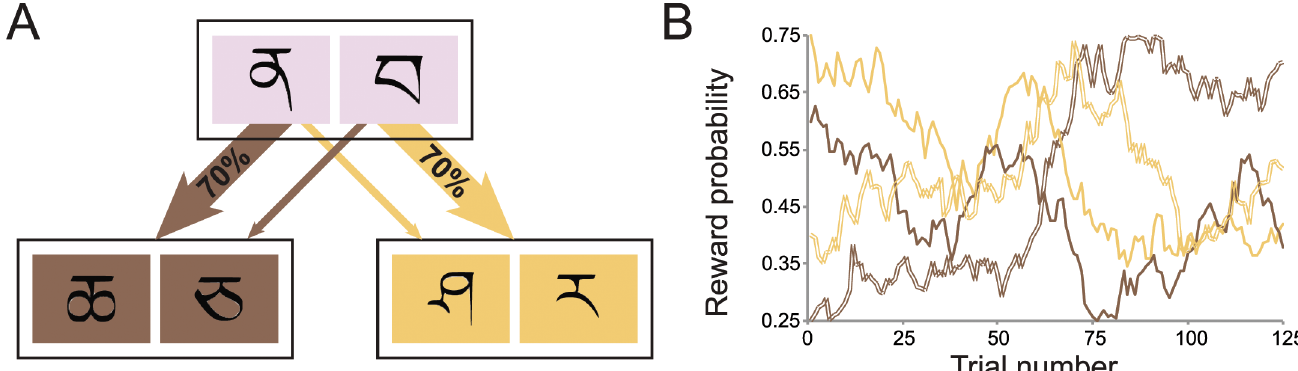
Fig 1. Design of the Daw two-step task. (A) State transition structure of the original two-step paradigm. Each first-stage choice has a high probability of transitioning to one of two states and a low probability of transitioning to the other. Each second-stage choice is associated with a probability of obtaining a binary reward. (B) To encourage learning, the second-stage reward probabilities change slowly over the course of the experiment.